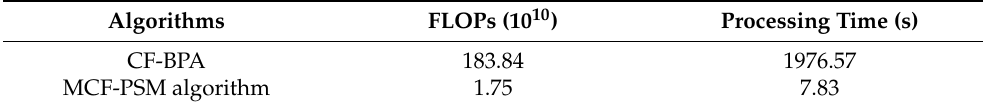
Table 5. Computational Costs of Different